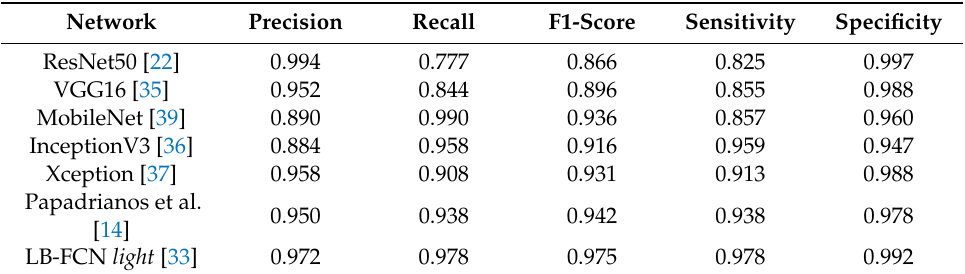
Table 2. Comparative classification performance for the healthy class.